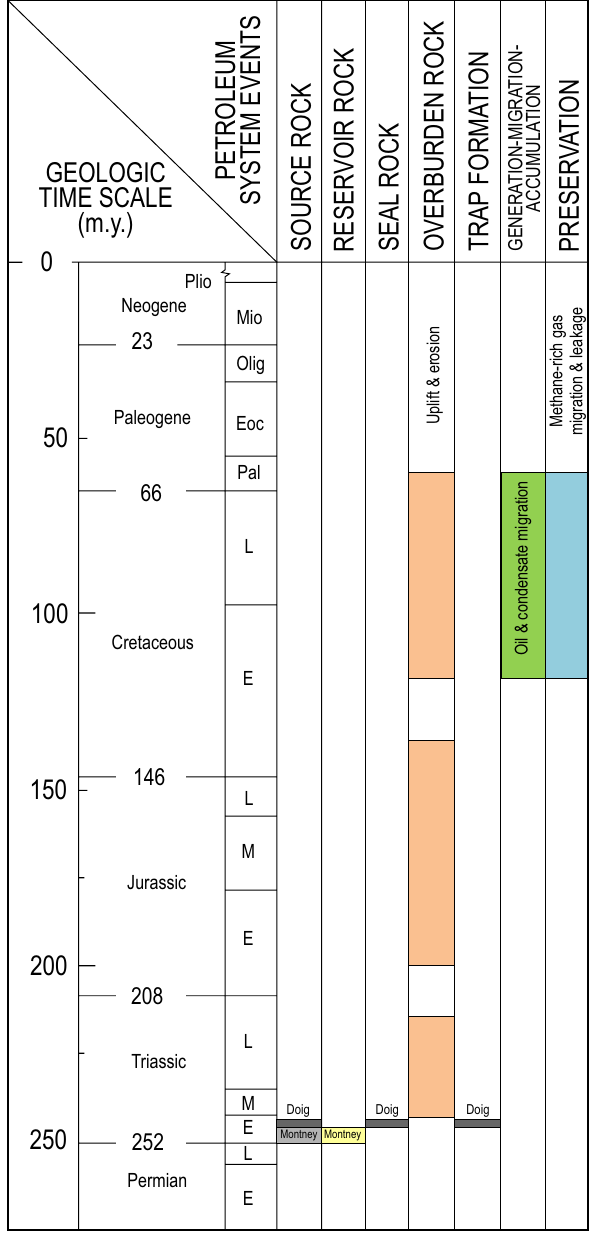
Figure 2. Petroleum system events chart 29 for the Montney-Doig unconventional tight-petroleum system. Events are based mainly on information from Henderson et al. 27 , Ness 30 , and Ducros et al. 31 . Overburden rock, generation-migration-accumulation and preservation events are tied to timing of burial and uplift which varies significantly with geographic position in the Western Canadian Sedimentary Basin 30,31 . m.y. million years, E early, M middle, L